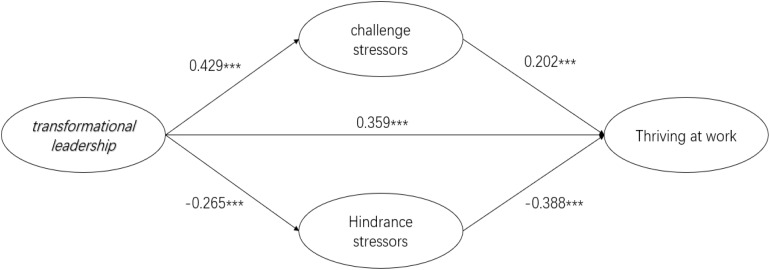
Model path analysis. ***p < 0.001; **p < 0.01; and *p < 0.05.